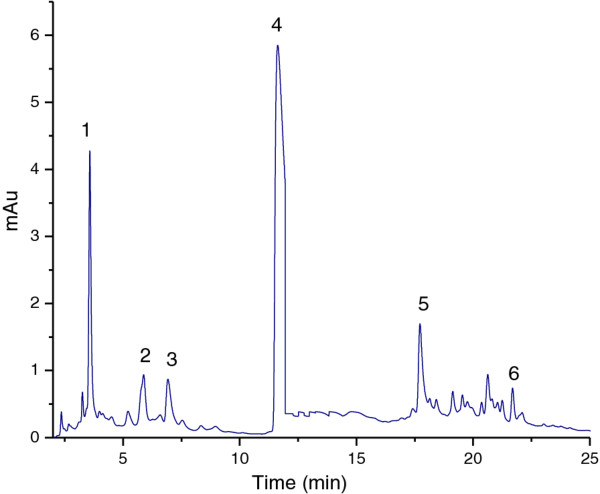
HPLC chromatogram of tea polyphenols. The peak numbers indicate: 1, EGC, tR = 3.6; 2, C, tR = 5.81; 3, EC, tR = 6.99; 4, EGCG, tR = 11.71; 5, CAF, tR = 17.73 and 6, ECG, tR = 21.67.